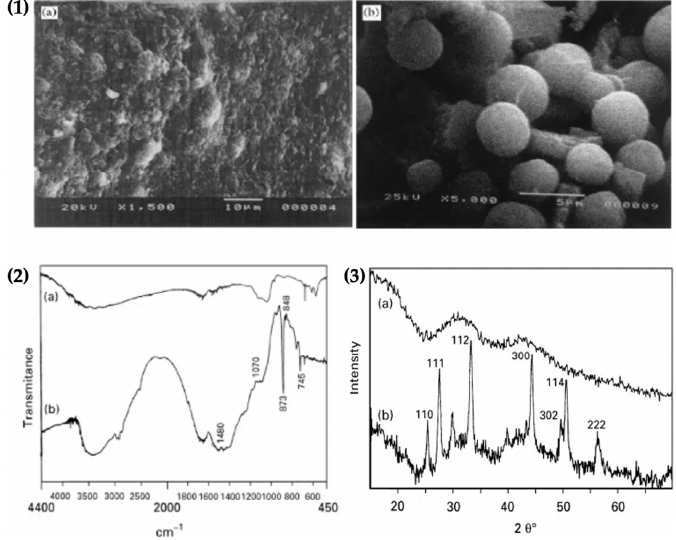
Figure 13. ( 1 ) Scanning electron micrographs: ( a ) fibrin substrate; ( b ) vaterite crystals on fibrin, Ca5 "3]10~3M, pH"8.5, 253C; ( 2 ) FTIR spectra of: ( a ) fibrin; ( b ) vaterite grown on fibrin, and ( 3 ) Powder X-ray diffraction spectra of: ( a ) fibrin; ( b ) vaterite grown on fibrin. Adopted with permission from